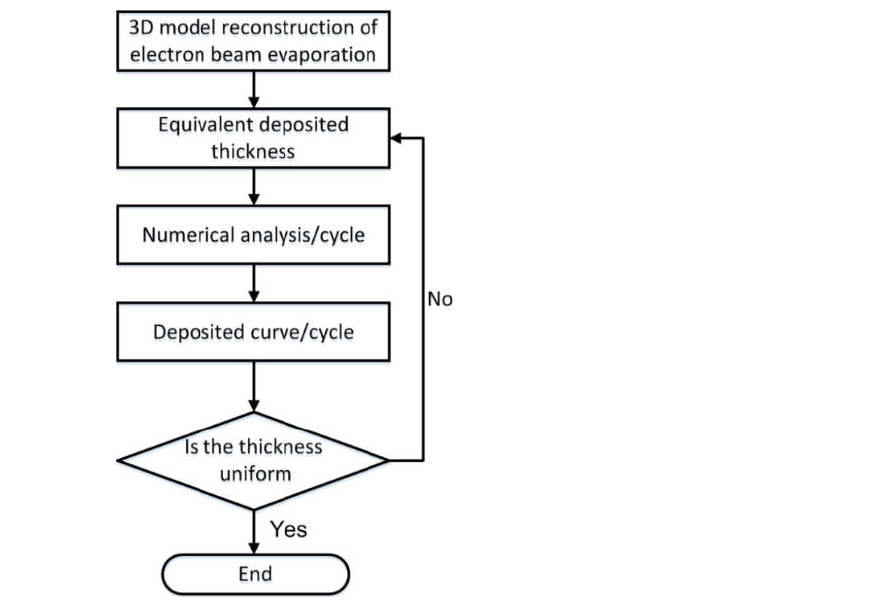
Figure 1. Flow chart of film thickness uniformity simulation for the coating experiment.